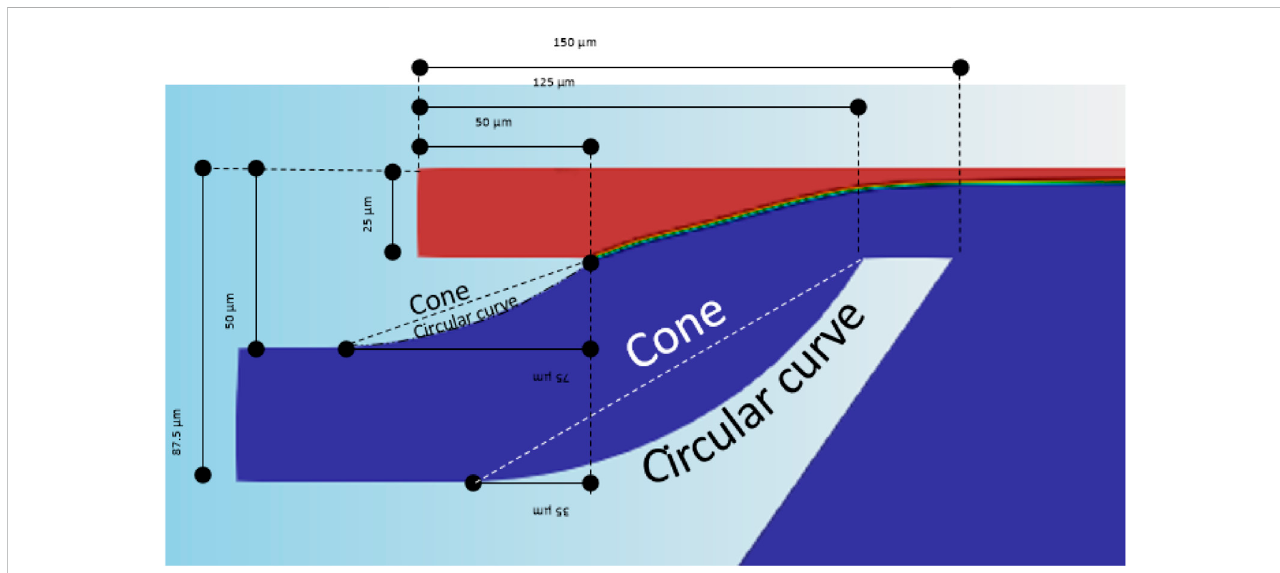
FIGURE 3 Geometry of the axis-symmetric cross-section of the cone- and bell-shaped nozzles. The circular curve geometry is used in the bell-shaped nozzles, while it is replaced by the straight line in the cone-shaped nozzle. The axis of symmetry is along the liquid jet (red). The inlets are shown on the left.